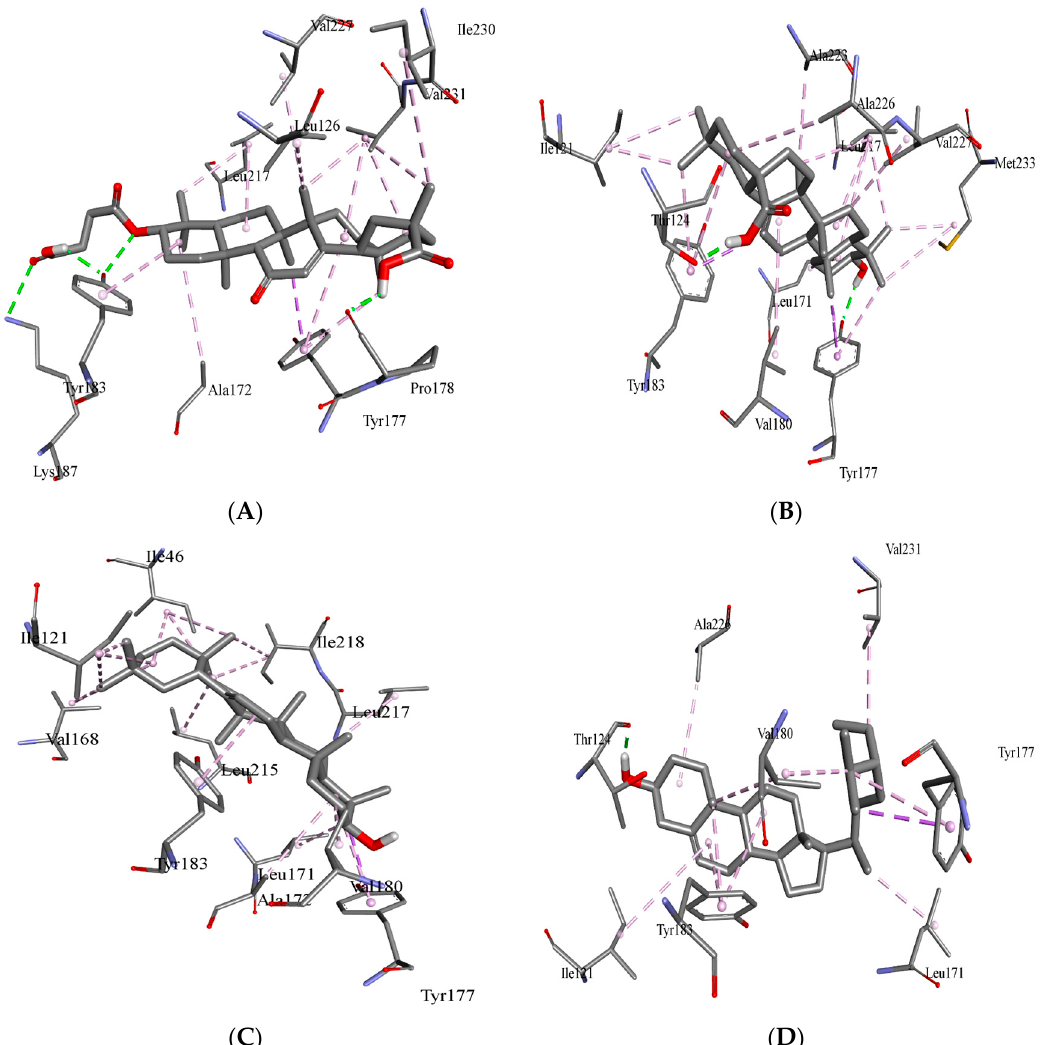
Figure 2. Binding orientation in the docked complex of the carbenoxolone acid ( A ) and oleanolic acid ( B ), β -sitosterol ( C ) and β -amyrin with 11 β -HSD1 ( D ). The image was generated using the Discovery Studio Visualizer. Table 1. Summary of selected constituents and reference compounds (carbenoxolone). Chemical structures Autodock docking scores, hydrogen bond interactions, and hydrophobic interaction res- idues.